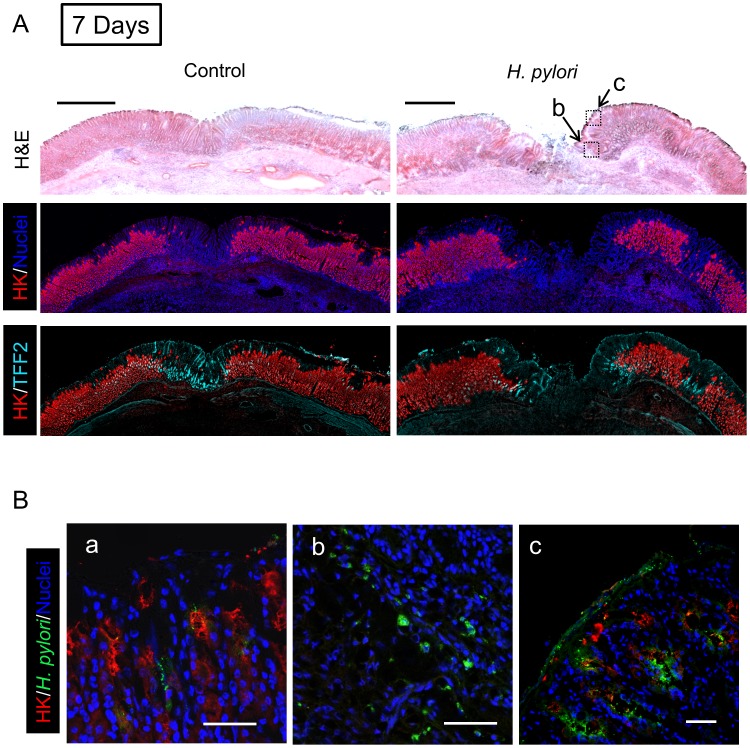
Morphology of gastric ulcerated tissue 7 days after H. pylori inoculation.Gastric tissue was isolated 9 days after ulcer induction (7 Days after H. pylori inoculum), and serial sections processed as described in Methods. (A) Sections of uninfected (control) or H. pylori infected tissues are compared as in Figure 4. Bar = 1 mm. (B) Tissue was also stained for H. pylori, and results presented as in Figure 4. Higher magnification of serial sections from (a) non-ulcerated corpus region of H. pylori infected stomach, or (b, c) around inset area indicated in A. Bar = 50 µm.